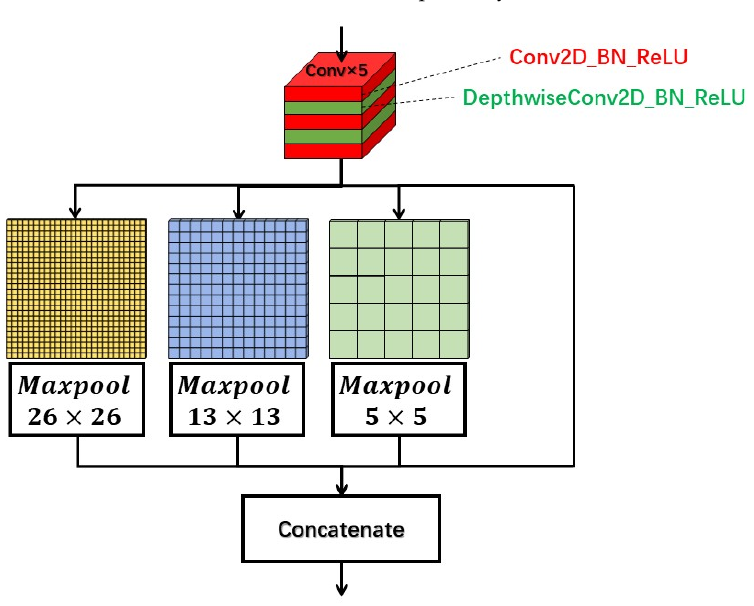
Figure 4. The structure of the Conv×5 module and spatial pyramid pooling (SPP).